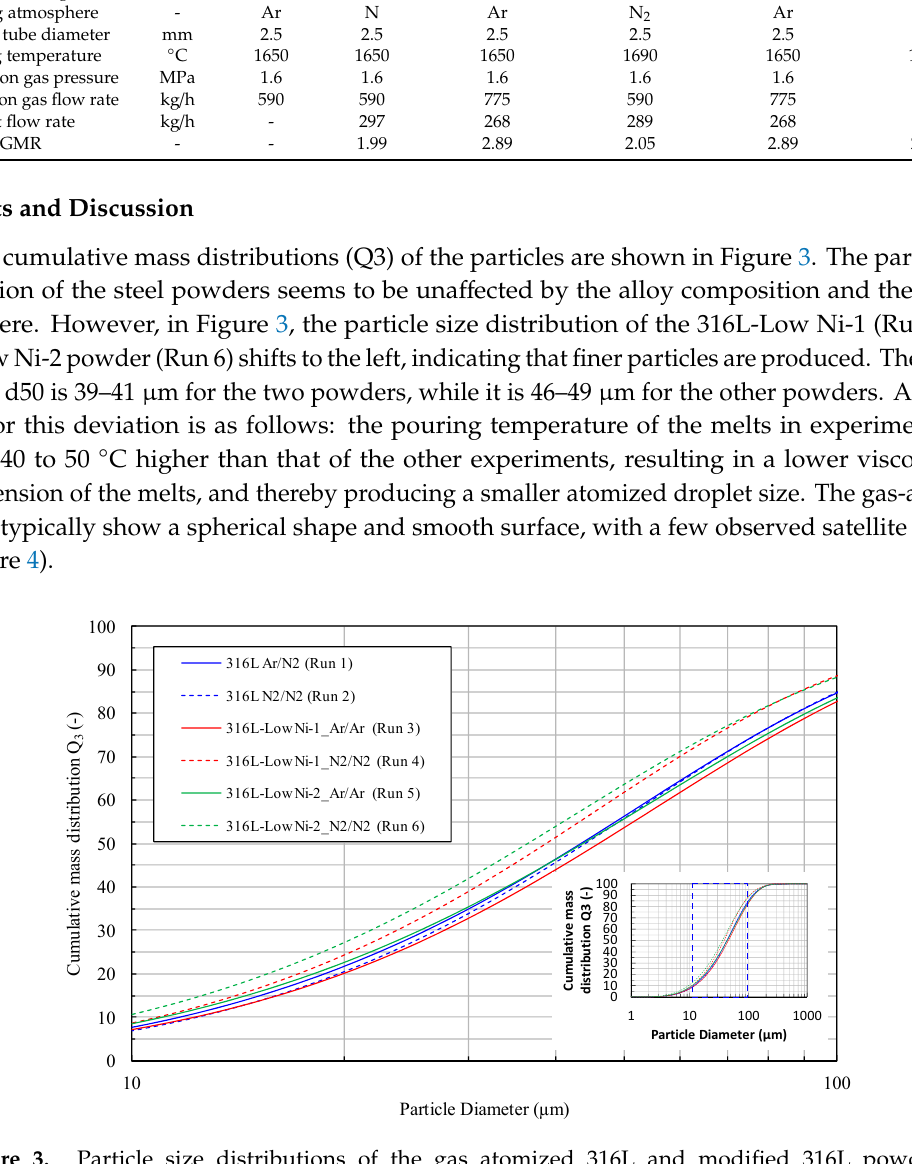
Figure 4. SEM images of gas atomized 316L and modified 316L steel powders (particle size < 200 µm): ( a ) 316L Ar/N2 (Run 1), ( b ) 316L N 2 /N 2 (Run 2), ( c ) 316L-Low Ni-1 Ar/Ar (Run 3), ( d ) 316L-Low Ni-1 N 2 /N 2 (Run 4), ( e ) 316L-Low Ni-2 Ar/Ar (Run 5), and ( f ) 316L-Low Ni-2 N 2 /N 2 (Run 6). A variety of shape parameters such as circularity, convexity, solidity, and aspect ratio are employed by the image analysis system Morphologi G3 to characterize the particle shape [29]. It is unlikely that a single shape parameter can perfectly characterize particles in all applications. For example, an application concerned with perfectly spherical particles could use circularity to measure any deviation. However, circularity would not be appropriate in an application where both ‘spikey’